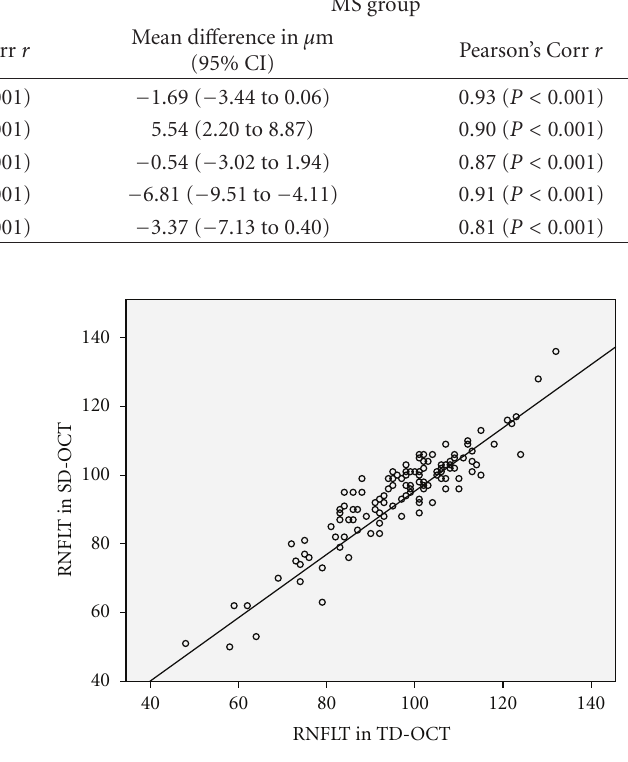
Figure 1: Correlation between average RNFLT in µ m in SD-OCT ( y -axis) and TD-OCT ( x